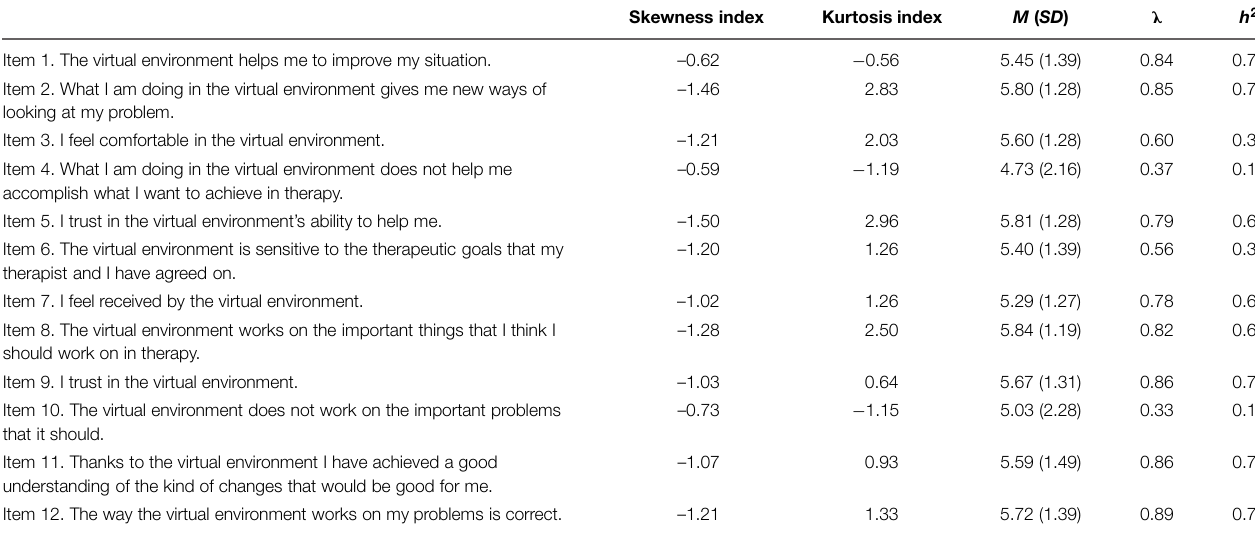
TABLE 2 | Psychometric properties of the WAI-VAR: Skewness and Kurtosis Index, Mean ( M ), and Standard Deviation ( SD ), factorial loadings ( λ ) with a one-factor structure using Maximum Likelihood (ML) and communalities ( h 2